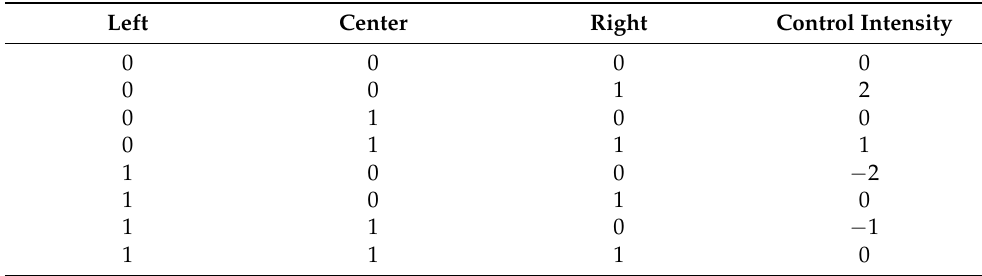
Table 1. Look-up table used for the line-tracking